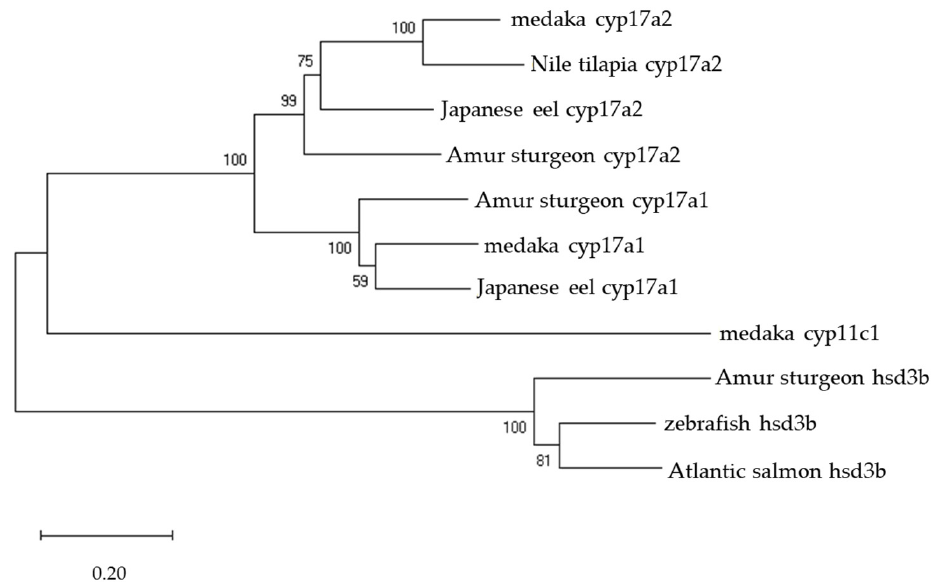
Figure 2. Phylogenetic tree of hsds3b , cyp17a1 , cyp17a2 , and cyp11c1 in teleosts. Phylogenic relation- ships among Amur Sturgeon hsd3b, zebrafish hsd3b, Atlantic salmon hsd3b, Amur sturgeon cyp17a1, rainbow trout cyp17a1, Japanese eel cyp17a1, medaka cyp17a1, Amur sturgeon cyp17a2, Japanese eel cyp17a2, medaka cyp17a2, Nile tilapia cyp17a2 and medaka cyp11c1 were determined. Numbers are the percentage of 1000 replicates in which the associated taxa clustered together in the bootstrapping test, indicating reliability. The scale bar is indicated at the bottom.